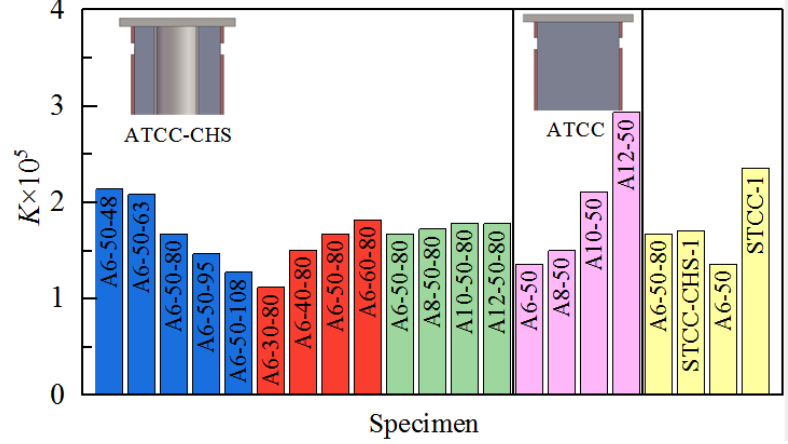
Figure 6. N - Δ relationships. ( a ) Diameter – thickness ratio, ( b ) hollow rate, ( c ) concrete strength, ( d ) material of the outer tube, and ( e ) ATCC.